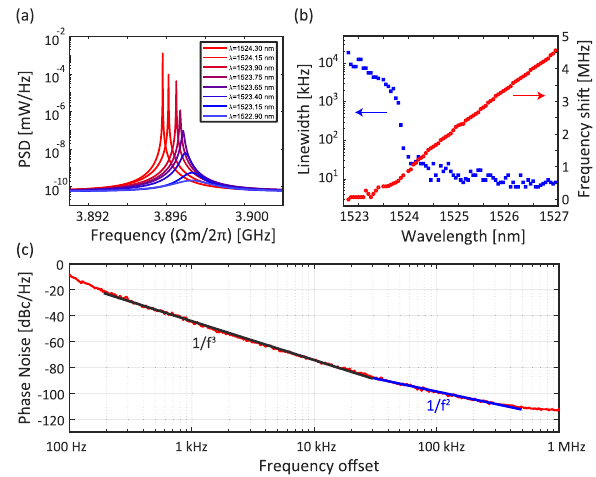
Figure 3: Driving the optomechanical (OM) crystal cavity to the phonon lasing regime at P in (cid:1) 2 . 48 mW. (a) Detected RF spectra at different driving wavelengths ( λ L ) . (b) Evolution of the mechanical effective linewidth and the mechanical frequency as a function of λ L for a driving power P in (cid:1) 2 . 48 mW. (c) Phase noise of the generated microwave tone in red and fi t to 1/ f 3 and 1/ f 2 lines as described by the Lesson ’ s model. The phase noise at 100 kHz is ( − 100 ± 1) dBc/Hz.